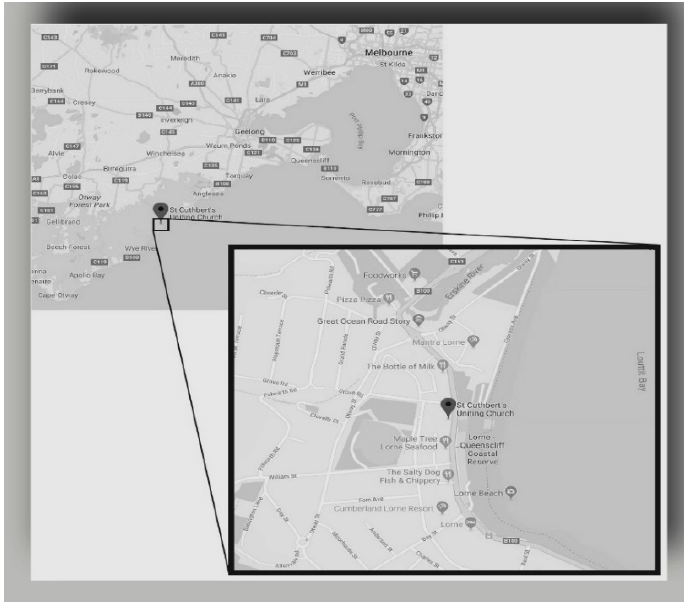
Figure 3. Locational map of St. Cuthbert’s, Lorne, Victoria. Source: www.google.com/maps [24]. Commons licence.